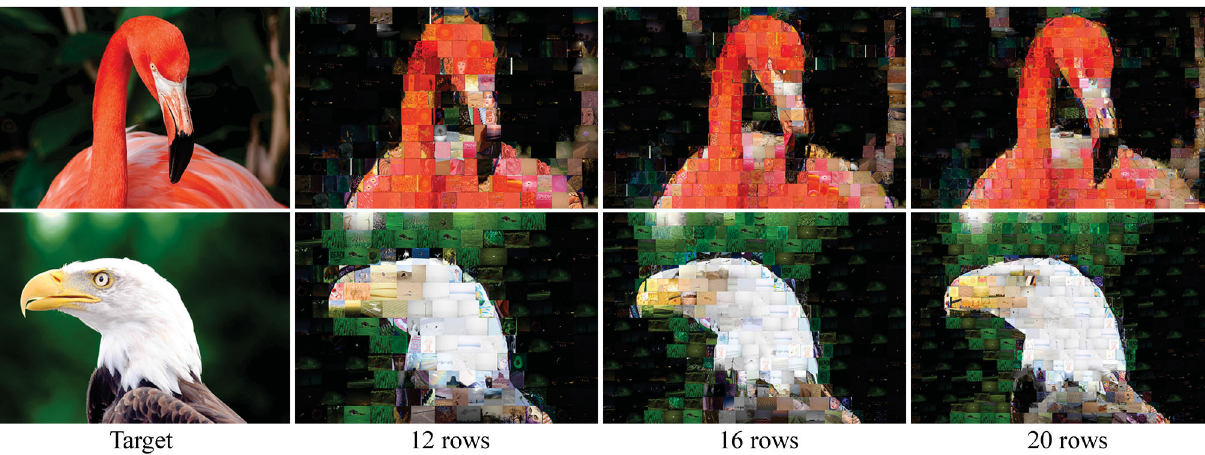
Fig. 9 Our method can produce high-quality image mosaics which preserve the edges of the target image, even when using few rows.